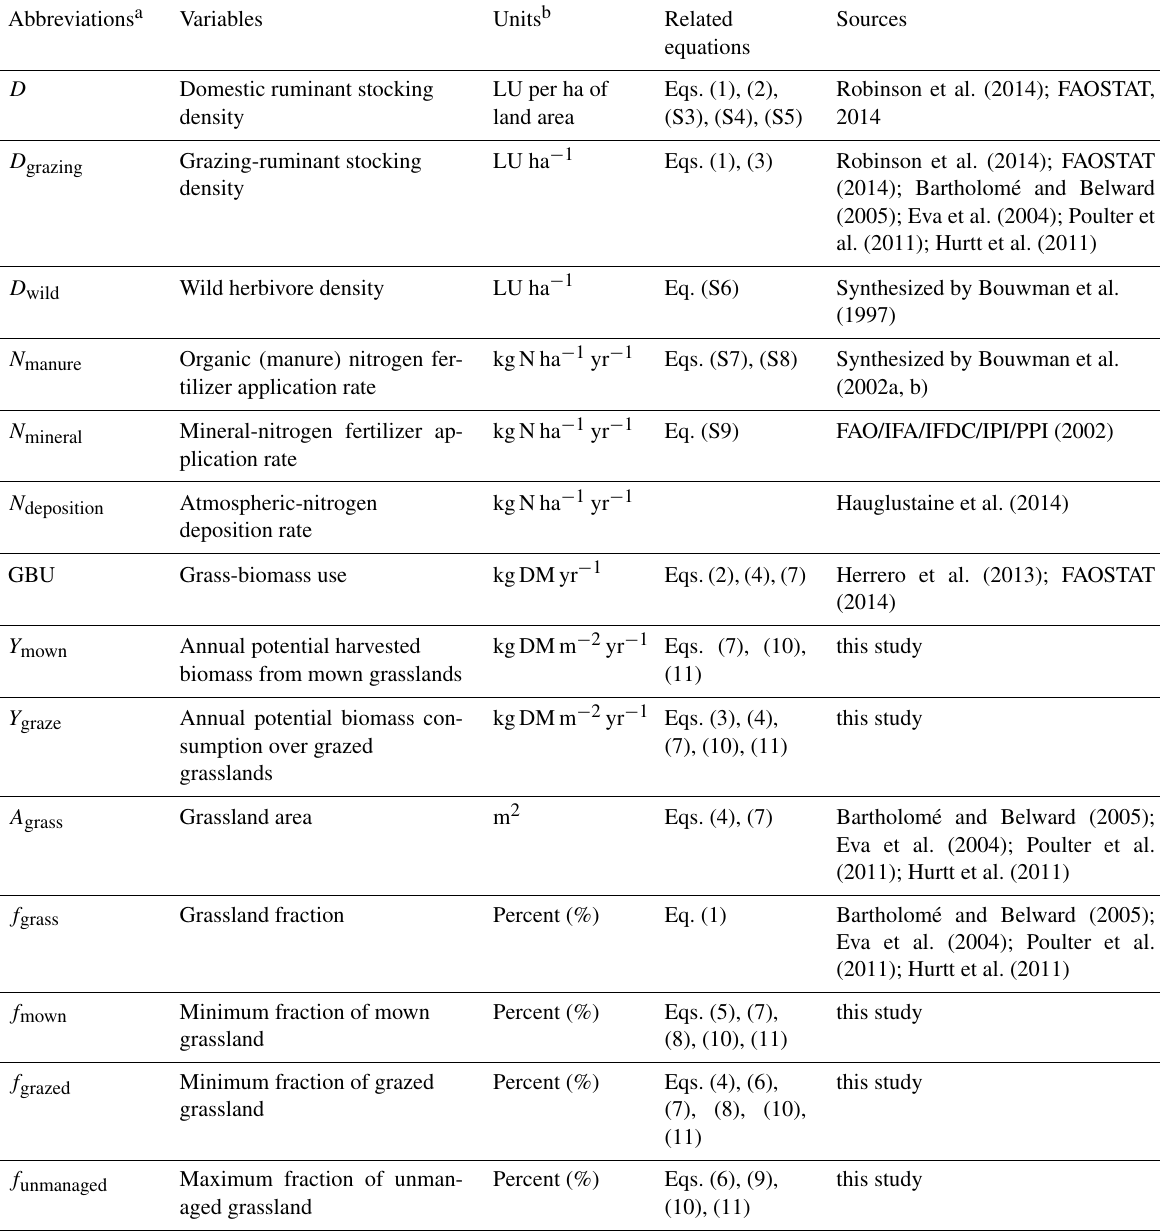
Table 1. The abbreviations, units, related equations, and data sources of the variables shown in this study. Abbreviations